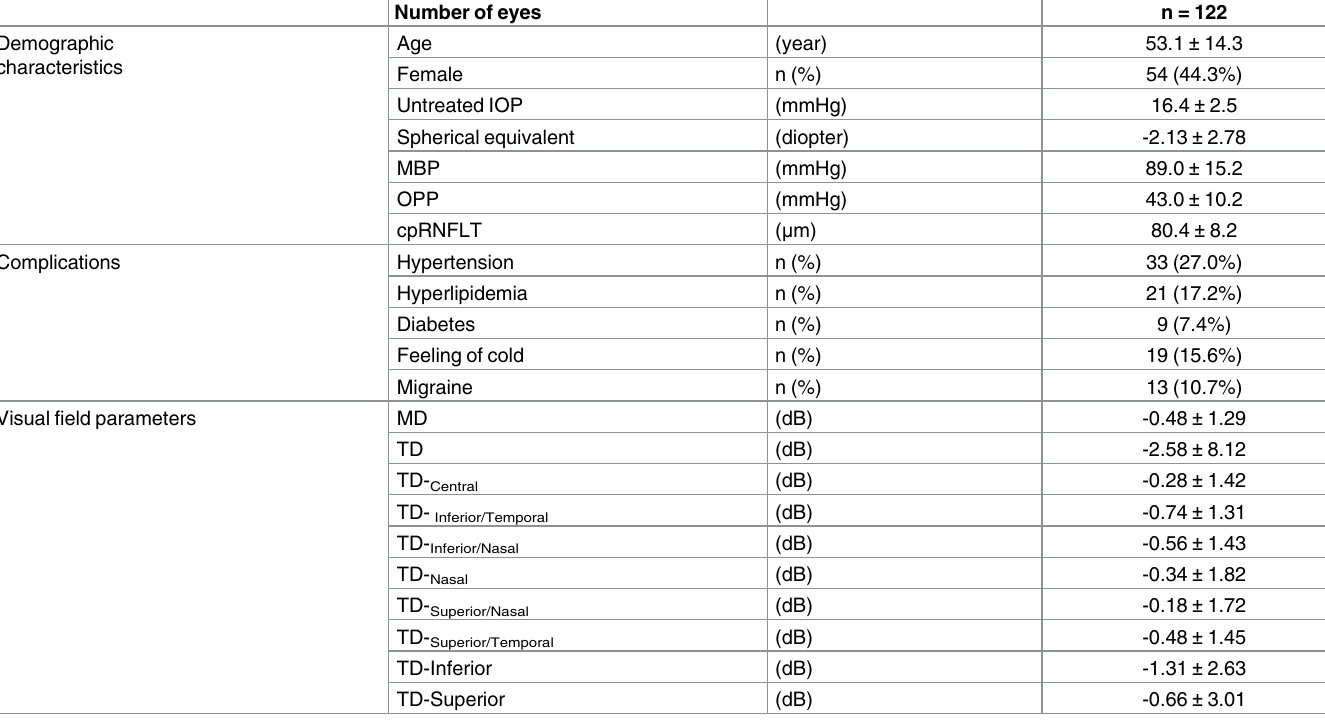
Table 1. Baseline demographic/characteristics of preperimetric glaucoma